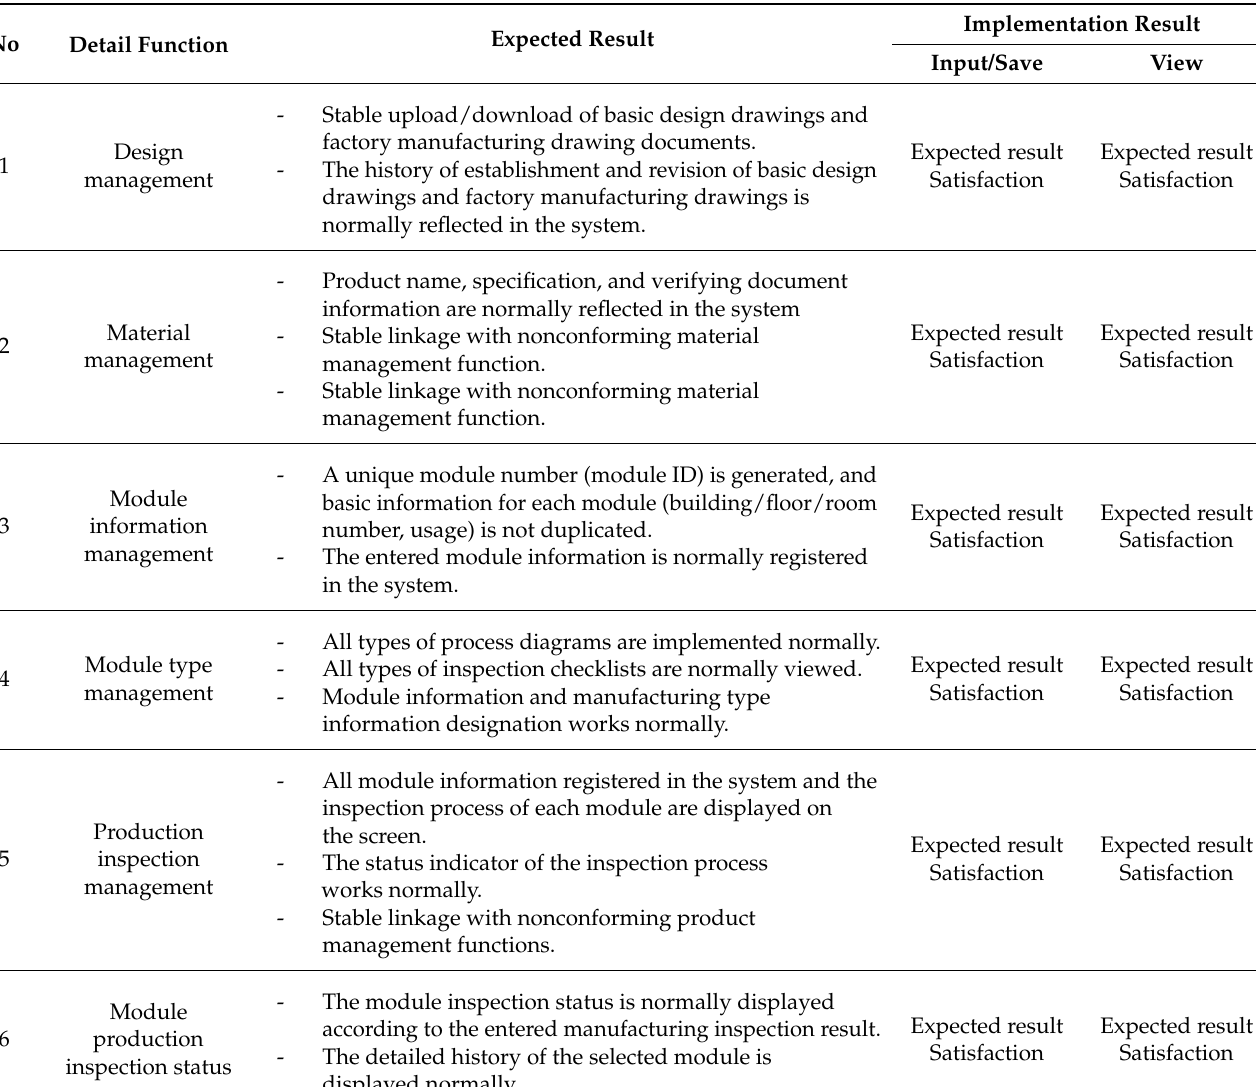
Table 3. Developed system performance test